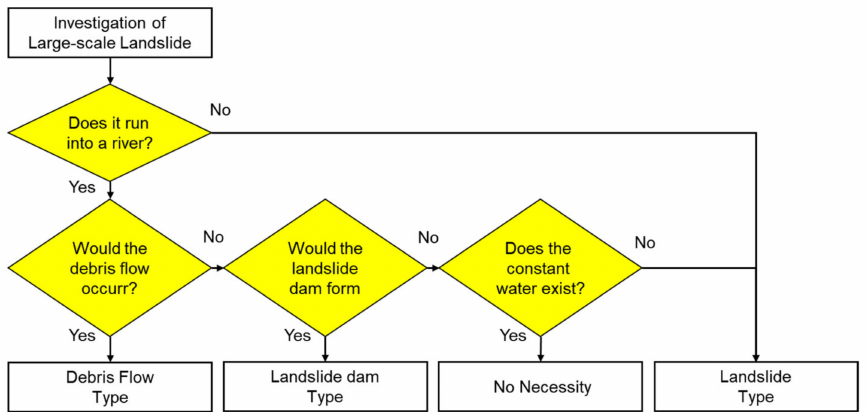
Figure 4. Flowcharts of disaster classification for large-scale landslides (Tsai et al.,